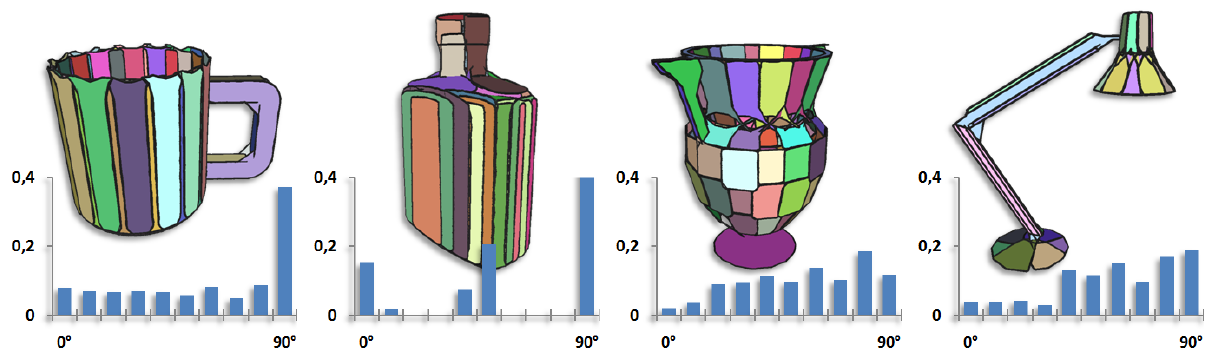
Figure 3: Pairwise Orientation. The distribution of pairwise orientation helps distinguishing different curved objects. The cylindrical shape of the mug is translated into a mostly uniform distribution with a peak owing to the bottom. The orientation distribution for the vase (middle right) reflects the bulgy body by a broader range of angles compared to the lamp (far right).